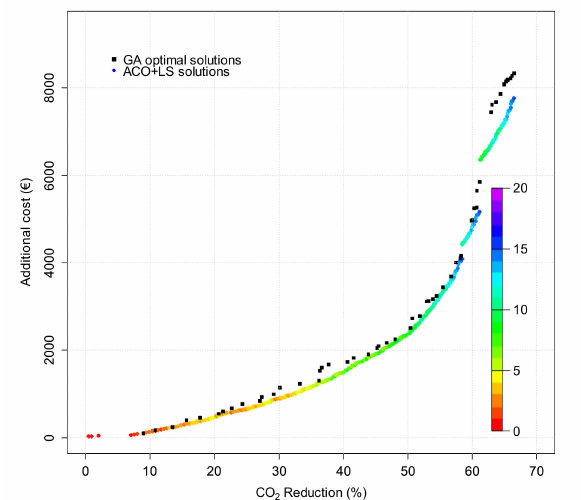
Figure 1. Comparison of CO 2 reduction and cost for optimal configurations found by GA and ACO + LS. Black squares represent GA configurations while colored (or grey) dots represent ACO + LS configurations. The color (or gray shade) represent the configuration